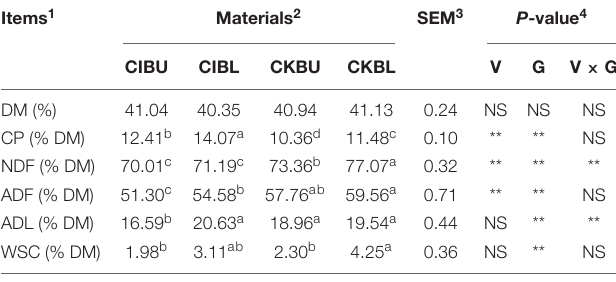
TABLE 1 | Chemical composition of fresh Caragana before ensiling ( n =